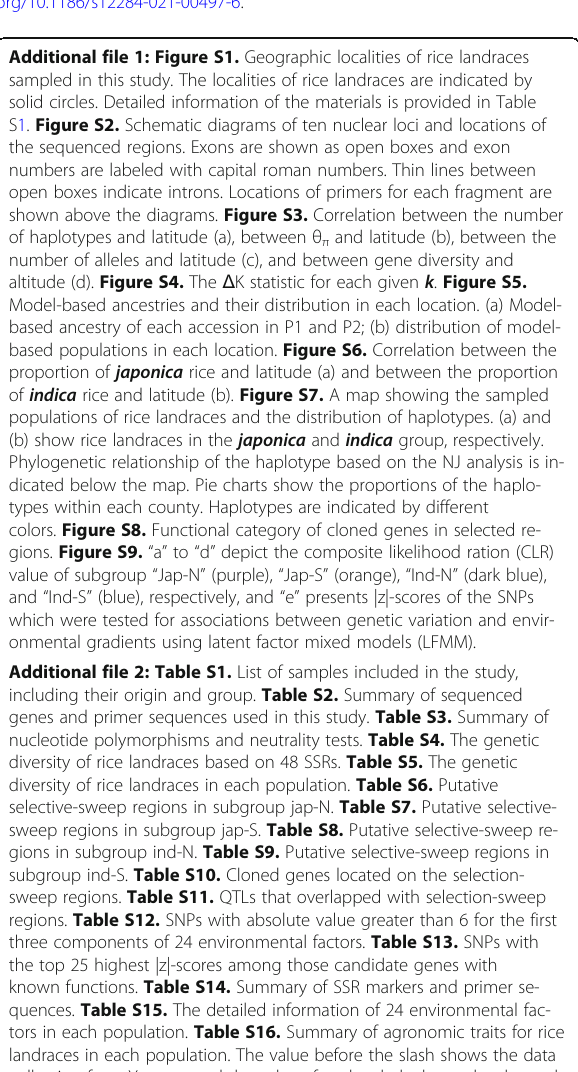
Additional file 2: Table S1. List of samples included in the study, including their origin and group. Table S2. Summary of sequenced genes and primer sequences used in this study. Table S3. Summary of nucleotide polymorphisms and neutrality tests. Table S4. The genetic diversity of rice landraces based on 48 SSRs. Table S5. The genetic diversity of rice landraces in each population. Table S6. Putative selective-sweep regions in subgroup jap-N. Table S7. Putative selective- sweep regions in subgroup jap-S. Table S8. Putative selective-sweep re- gions in subgroup ind-N. Table S9. Putative selective-sweep regions in subgroup ind-S. Table S10. Cloned genes located on the selection- sweep regions. Table S11. QTLs that overlapped with selection-sweep regions. Table S12. SNPs with absolute value greater than 6 for the first three components of 24 environmental factors. Table S13. SNPs with the top 25 highest |z|-scores among those candidate genes with known functions. Table S14. Summary of SSR markers and primer se- quences. Table S15. The detailed information of 24 environmental fac- tors in each population. Table S16. Summary of agronomic traits for rice landraces in each population. The value before the slash shows the data collection from Yunnan, and the value after the slash shows the data col- lection from